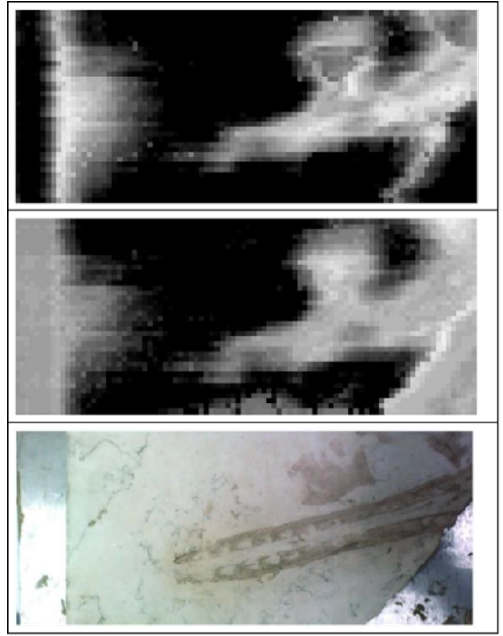
Figure 35. Summed modulus of parallel and cross-polarization scans at 6.7 GHz (top); summed modulus of scans 6.4 GHz, 6.5 GHz, 6.6 GHz, and 6.7 GHz parallel and cross-polarization (middle); and photograph of the lower side of the limestone slab aligned to correspond with the scanned area